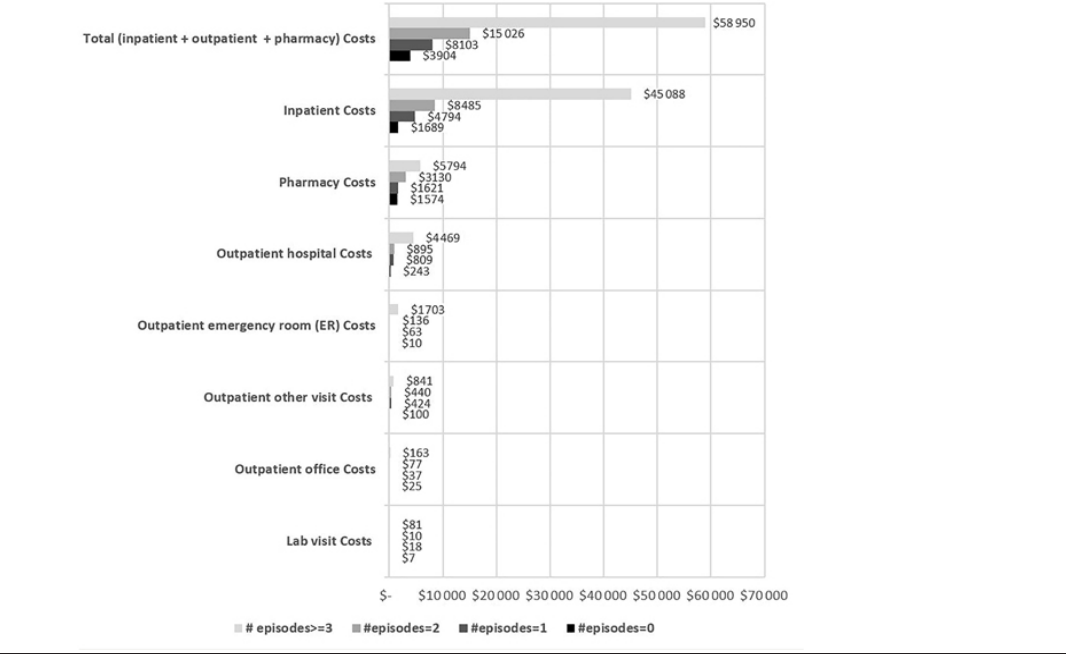
Figure 2b. SCD-related Medical Costs Stratified by Number of Pain Episodes in 1